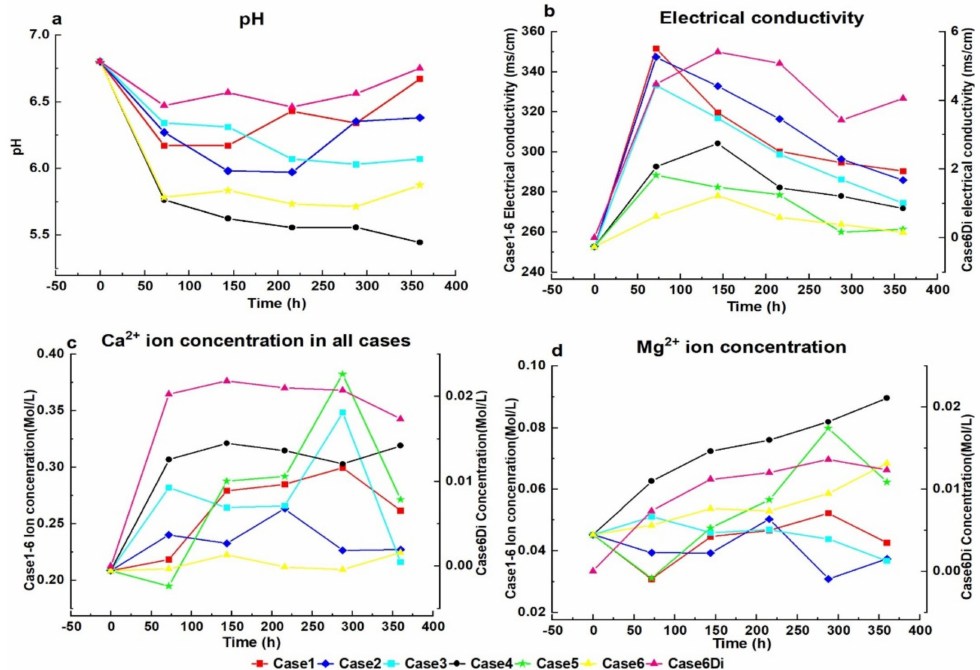
Figure 5. Evolution of the pH and electrical conductivity in brine during the experiments ( a , b ). Concentration changes of the major ions Mg 2+ and Ca 2+ ( c , d